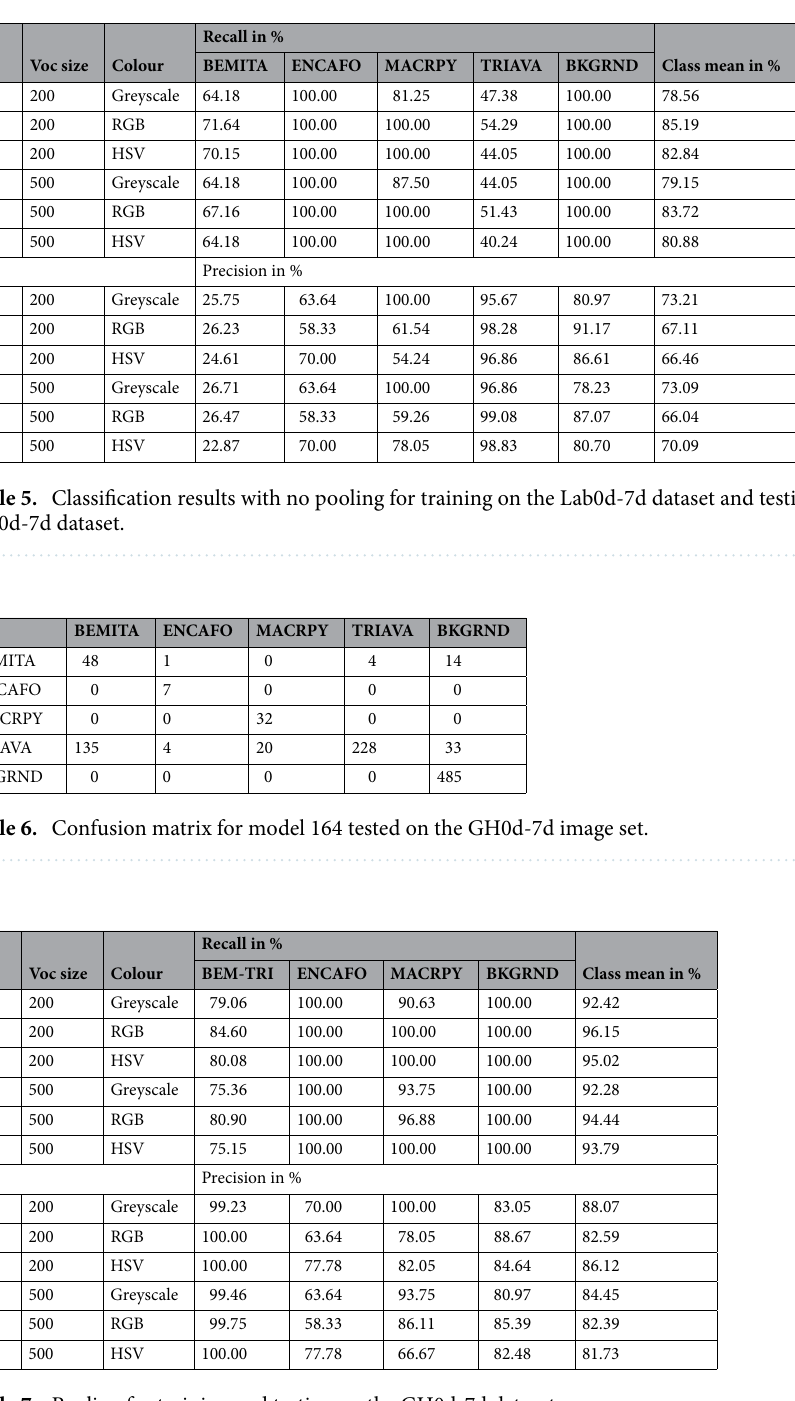
Table 7. Pooling for training and testing on the GH0d-7d